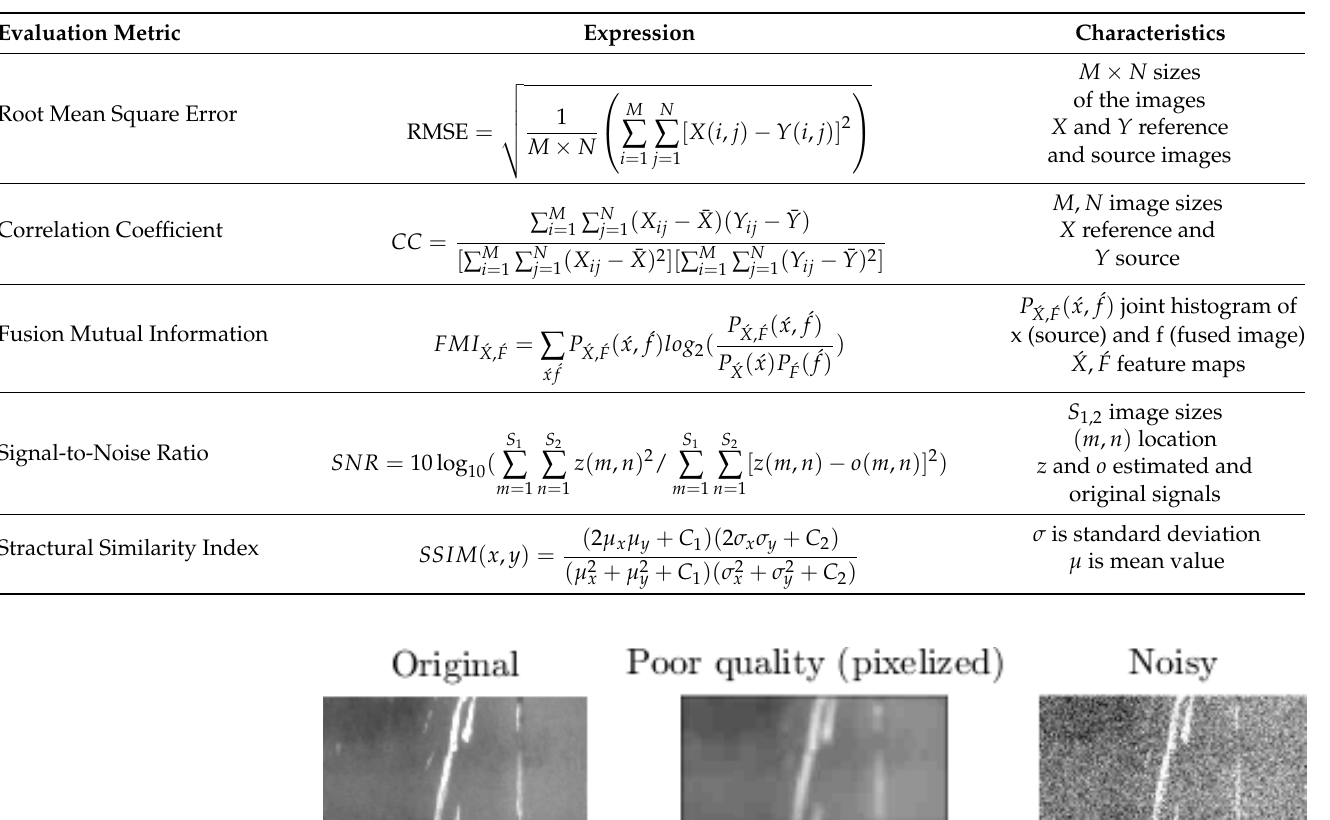
Table 8. Fusion performance evaluation metrics.